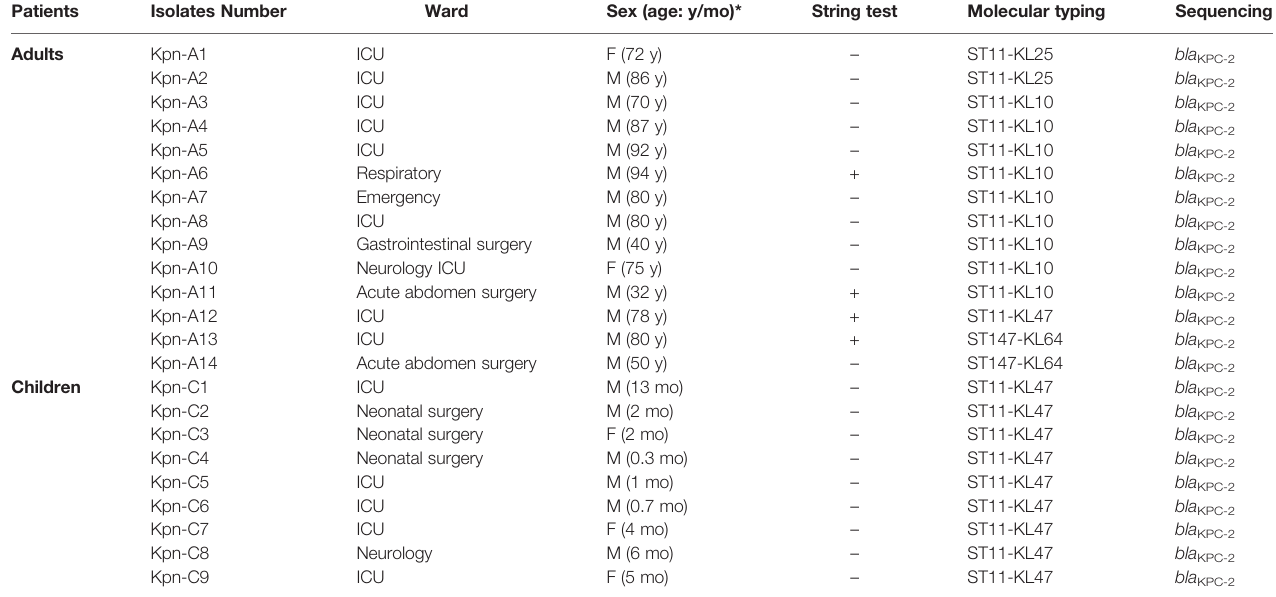
TABLE 2 | Summary of bla KPC positive Kpn